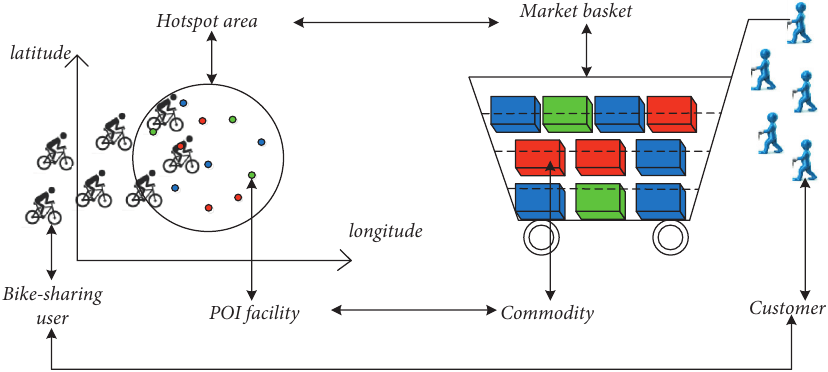
Figure 5: Model for riding characteristics similar to market basket analysis.